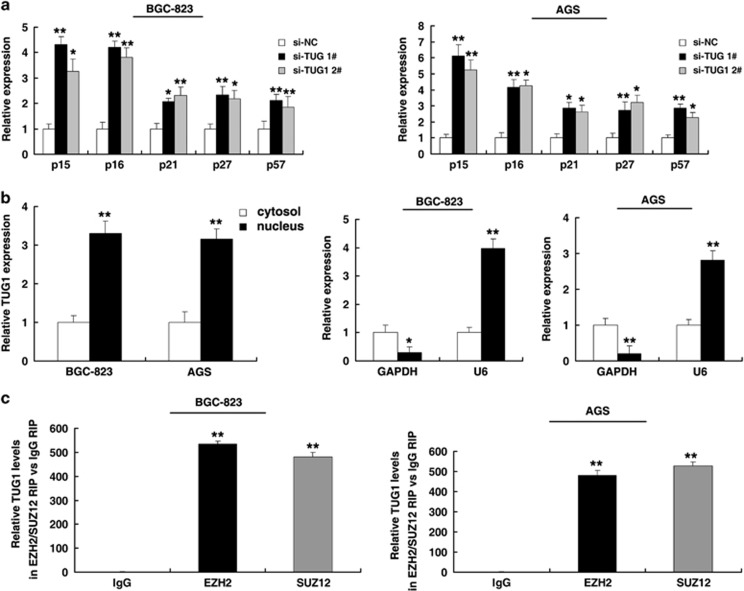
TUG1 is associated with PRC2 in GC. (a) The expression of p15, p16, p21, p27 and p57 was determined after knockdown of TUG1 using qRT-PCR. (b) TUG1 nuclear localization, as identified using qRT-PCR in fractionated BGC-823 and AGS cells. After nuclear and cytosolic separation, RNA expression levels were measured by qRT-PCR. GAPDH was used as a cytosolic marker, and U6 was used as a nuclear marker. (c) RIP experiments were performed, and the coprecipitated RNA was subjected to qRT-PCR for TUG1. The fold enrichment of TUG1 in RIPs is relative to its matching IgG control RIP. *P<0.05, **P<0.01